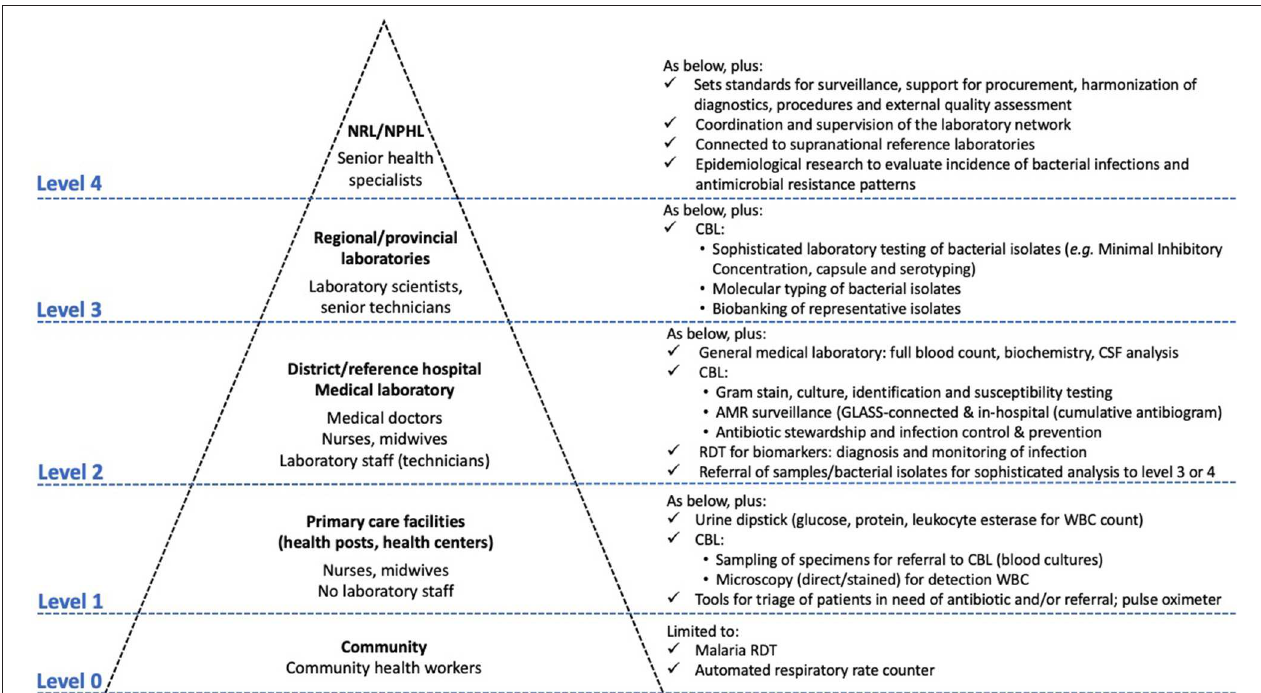
FIGURE 2 | The integrated Tiered Laboratory Network with focus on test menus relevant to clinical bacteriology at different levels-of-care. Clinical bacteriology has recently moved from Level ≥ 3 to Level 2, i.e., the district or referral hospital. Adapted from Unicef and WHO ( 37), Best and Sakande (39), WHO (47), Centers for Disease Control and Prevention (48), Unitaid (24), and WHO (49), which provide complementary information for the tiered work-up of HIV, tuberculosis and malaria and other diagnostics. CBL, clinical bacteriology laboratory; GLASS, Global Antimicrobial Resistance Surveillance System; RDT, rapid diagnostic